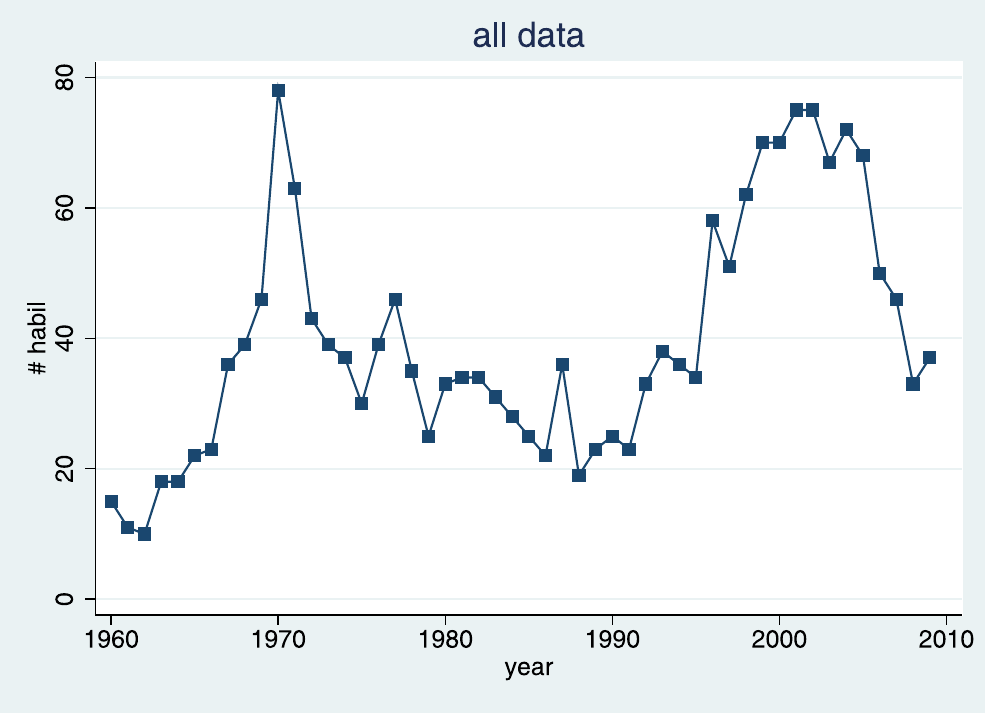
Fig 2. Production of Law Professors. Total number of habilitations per